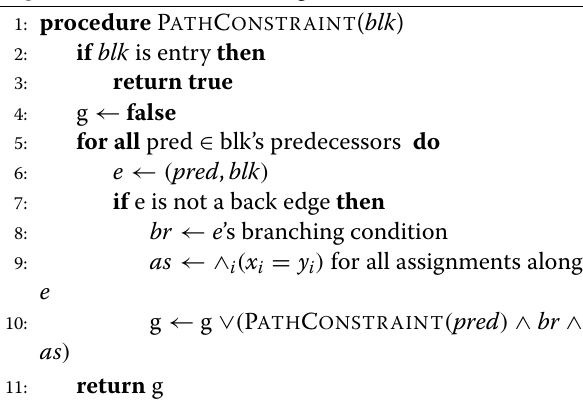
Algorithm 2 Path constraint generation